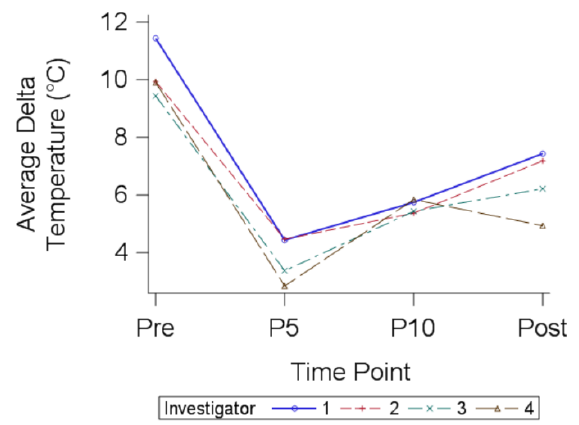
Figure 3. Longitudinal median delta temperatures for each investigator. No significant differences were found between investigators taking thermal readings. Investigator 1 ( n = 24), Investigator 2 ( n = 25), Investigator 3 ( n = 5), Investigator 4 ( n = 6).